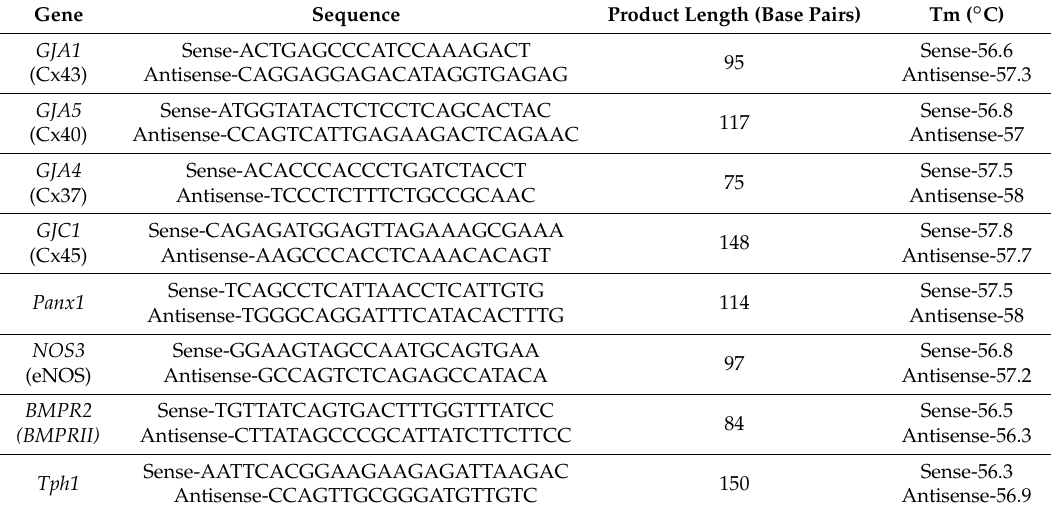
Table 4. TaqMan probe primers and their sequences for qPCR